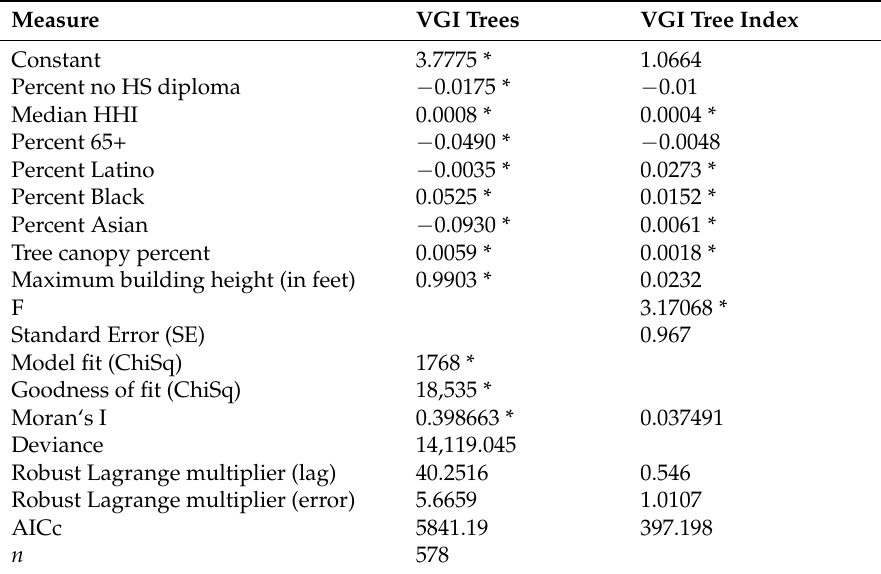
Table 4. San Francisco analytical